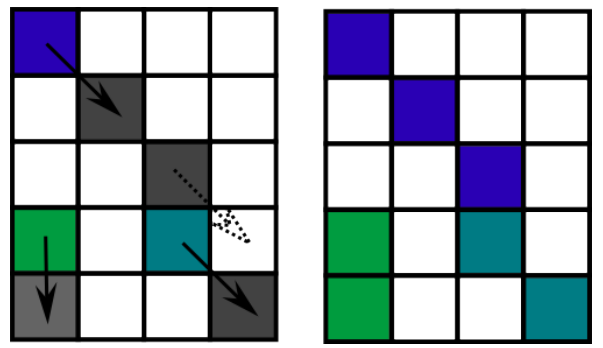
Figure 6: First segmentation step. Left: coloured starting pixel to each segment. The arrows show the direction for corresponding neighbours. Right: resulting segments